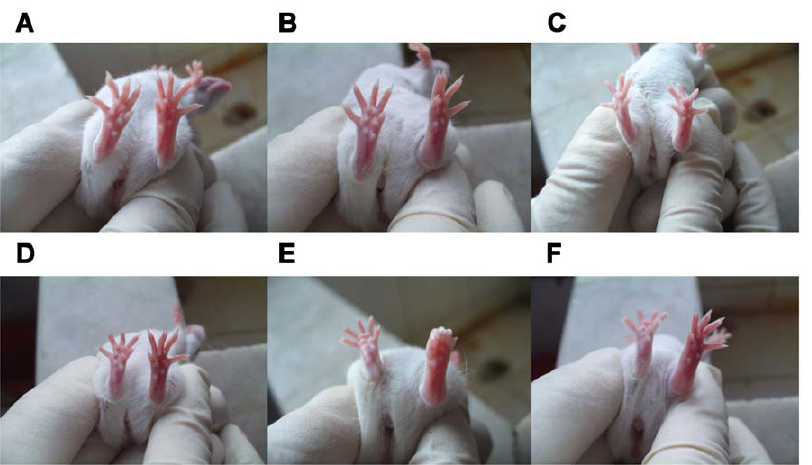
Figure 6. Articular inflammatory manifestations in mice after intra-articular injection with SNP, CII-CFA, or combined SNP and CII- CFA. A. Control; B. 20 m g SNP-injected mice; C. 40 m g CII-CFA-injected mice; D. 20 m g SNP + 40 m g CII-CFA-injected mice; E. 4 m g CII-CFA-injected mice; F. 20 m g SNP + 4 m g CII-CFA-injected mice. All photographes were taken after injection with SNP, CII-CFA, or combined SNP and CII-CFA for 1 d. doi:10.1371/journal.pone.0034494.g006 PLoS ONE |